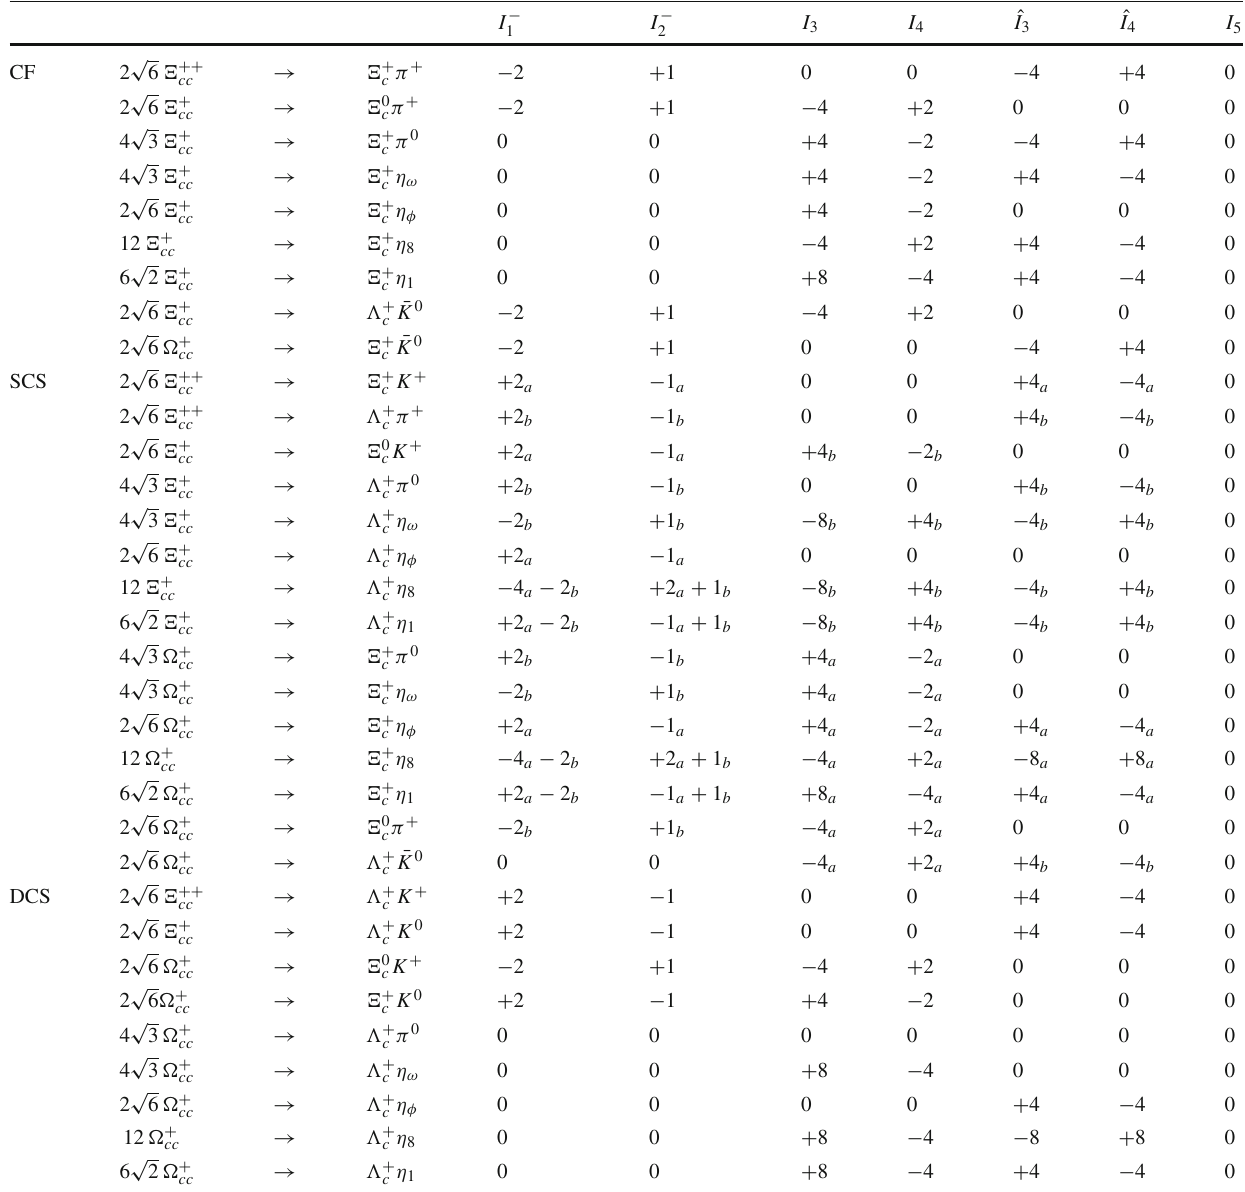
Table 10 Values of the seven topological tensor invariants for the CF, SCS and DCS decays of the triplet double charm baryon states (cid:6) ++ cc , (cid:6) + (cid:10) + cc and cc into the antitriplet single charm baryon states